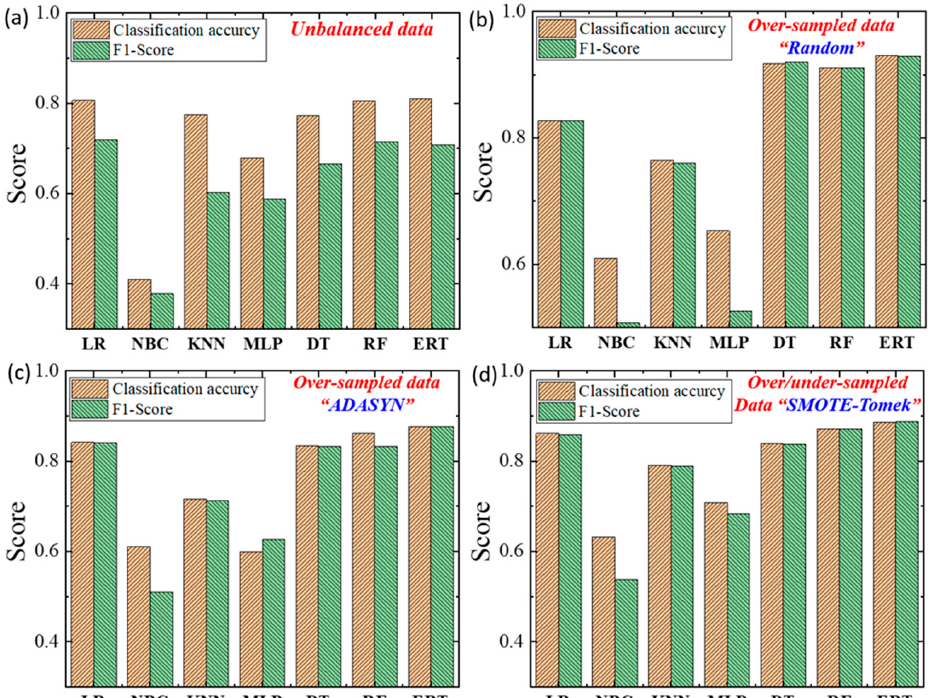
Figure 5. Testing results obtained using various machine learning algorithms, including LR, NBC, KNN, MLP, DT, RT, and ERT. These results were reached based on the initial dataset (unbalanced) ( a ) and those treated by different sampling methods, including over-sampling (Random) ( b ), over- sampling (ADASYN) ( c ), and over/under sampling (SMOTE-Tomek) ( d ).